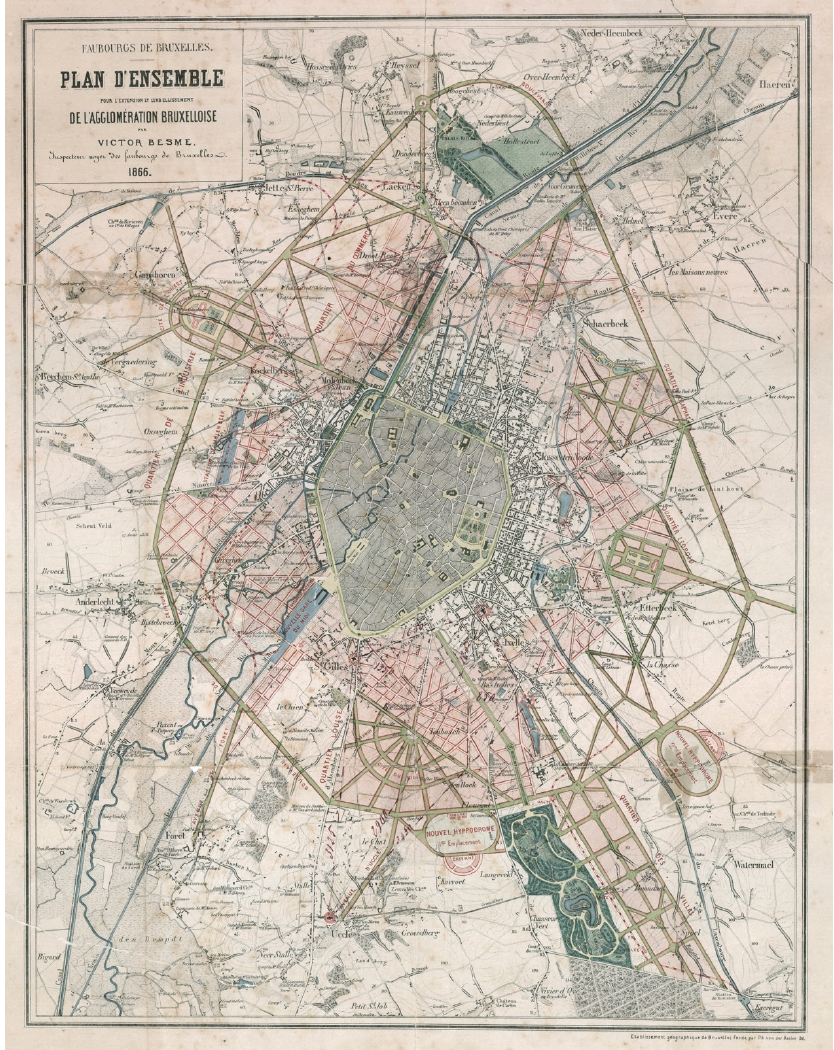
Figure 3. Plan D’ensemble pour L’extension et L’embellissement de L’agglomération Bruxelloise (Besme, 1866). Courtesy